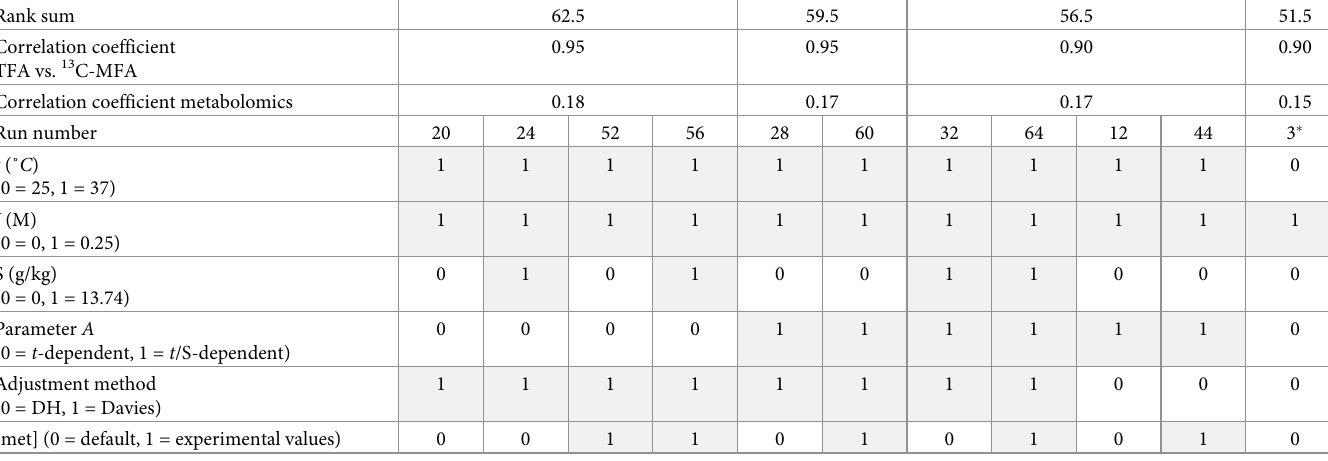
Table 4. Tests with the highest score in the joint ranking. The full list is available in (S4 Table). � (run #3) reflects the conditions used in the original